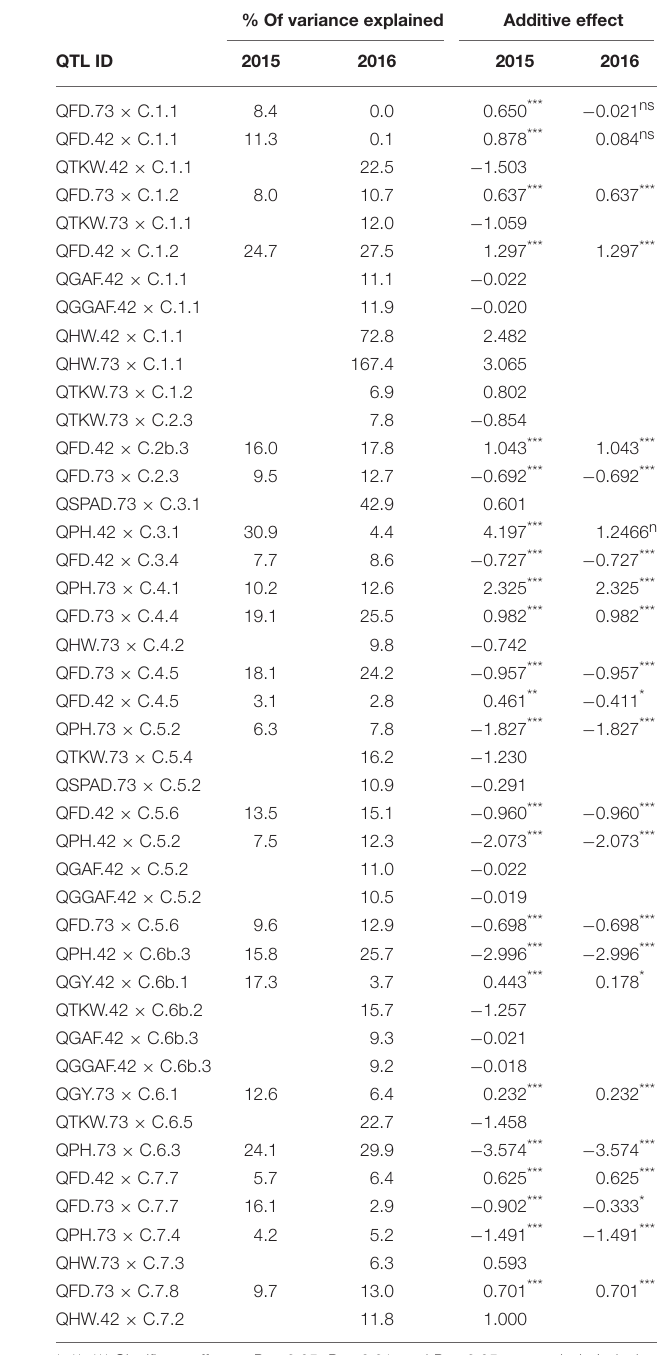
TABLE 4 | Percentage of variance explained for and additive effect (effect of replacing an allele from parent 1, Cierzo, with an allele from parent 2, landrace) of the QTLs found in the two barley BC 2 F 5 populations in 2015 and